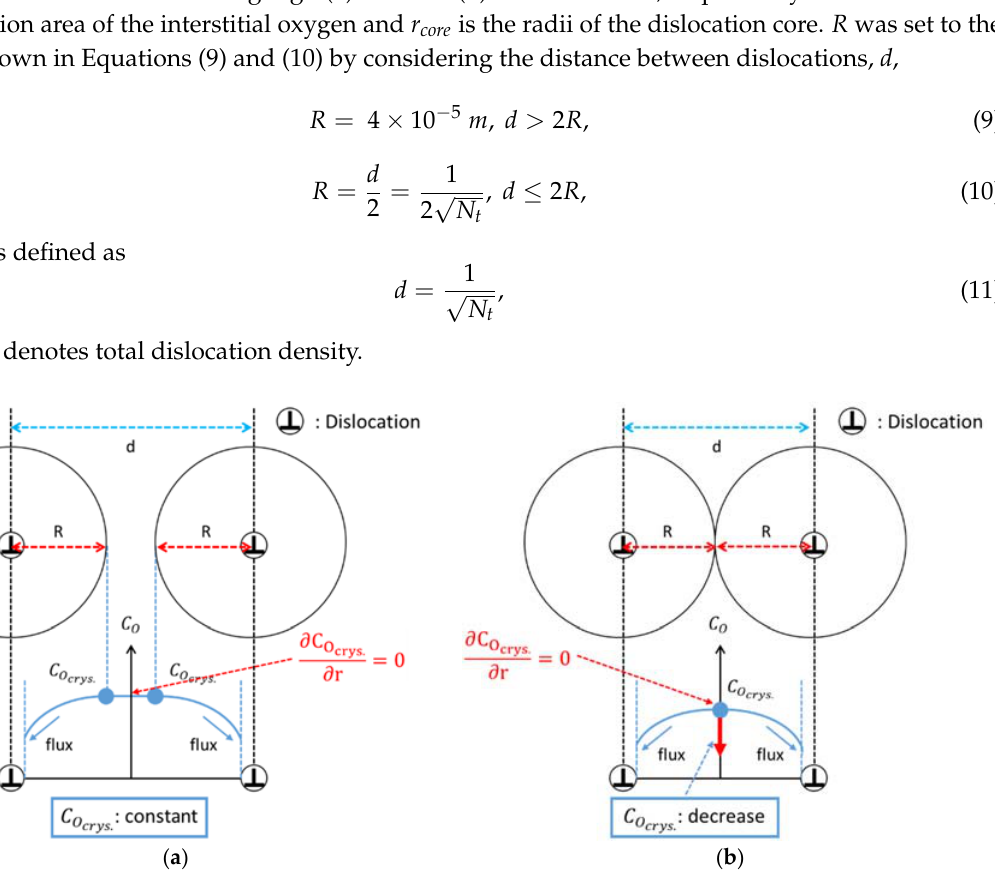
Figure 1. Diffusion model of interstitial oxygen into dislocation cores. The distributions of interstitial oxygen between two dislocations having high ( a ) and low ( b ) concentrations, respectively.